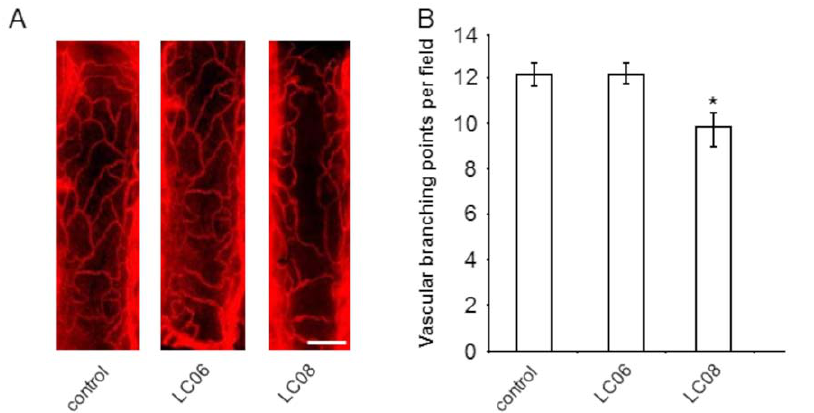
Figure 5. Effect of LC06 and LC08 on quiescent vessels. ( A ) Representative immunofluorescent pictures of CD31 stained tracheal whole mount sections of mice treated with control IgG 1 , LC06 and LC08. ( B ) Quantification of capillary branching points (in five random regions of 230 6 520 m m in each mouse whole mount trachea) reveals that pan-Ang-1/Ang-2 inhibition but not selective anti-Ang-2 treatment induced tracheal vessel regression (n=3–5; *p , 0.05 compared to control, Student’s t-test). The results were confirmed in two independent experiments. Results are expressed as mean 6 SEM. Scale bar represents 100 m m.